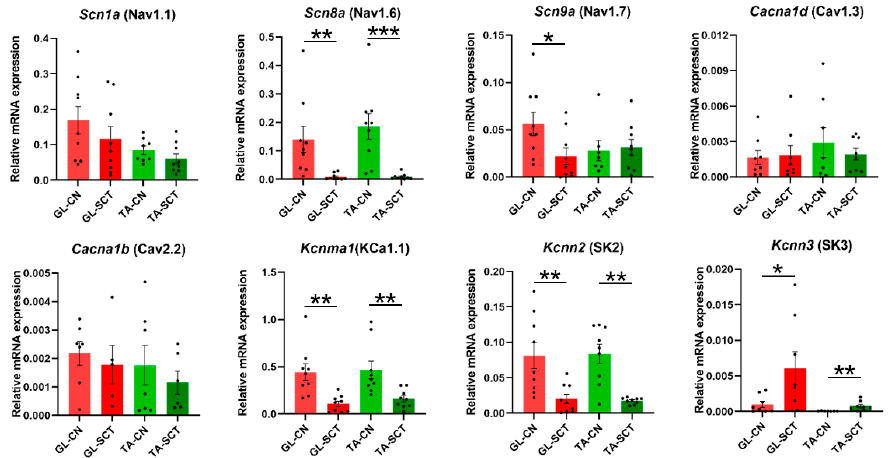
Figure 5. SCT downregulates the transcript level of the Nav1.6, KCa1.1 (BK), and SK2 channels similarly in GL and TA MNs. Expression of voltage-dependent Ca 2+ channels Cacna1d (Cav1.3) and Cacna1b (Cav2.2) was unaffected by SCT. Data are means +/ − SEM. Mann-Whitney U -test, * p < 0.05; ** p < 0.01; *** p < 0.001. The expression of two VG Ca 2+ channels, Cacna1b (Cav2.2) and Cacna1d (Cav1.3), in unaffected by SCT. Conversely, the expression of small-conductance Ca 2+ -activated K + (SK) channels was markedly changed (Figure 5). In GL and TA MNs of intact animals, Kccn2 (SK2) displayed the highest transcript level, followed by the Kccn3 (SK3), while the transcript level of Kccn1 (SK1) was extremely low, suggesting that SK2 undergoes exten- showing that SK2 protein is expressed in all α -MNs of the lumbar segment in the rat, whereas SK3 is expressed preferentially in small-diameter α -MNs [53]. Regulation of gene expression of SK2 and SK3 in response to the lesion was in the opposite direction: a sig- nificant decrease of the transcript level of Kccn2 (SK2), parallel in both groups of MNs, was accompanied by increased Kcnn3 (SK3) level (Figure 5). Highly abundant Kcnma1